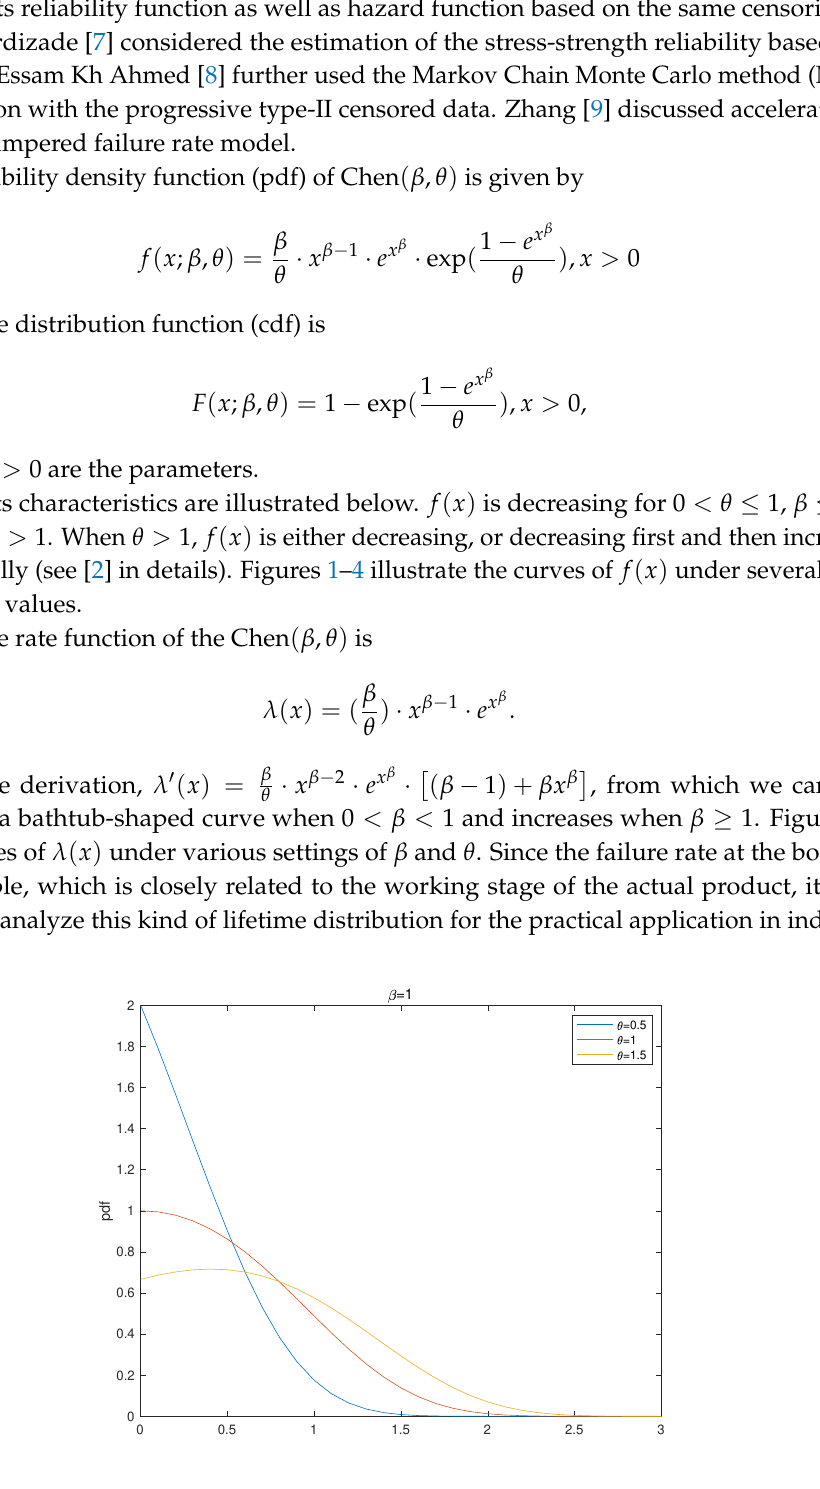
Figure 1. The probability density function (pdf) when β = 1, 0 < θ ≤